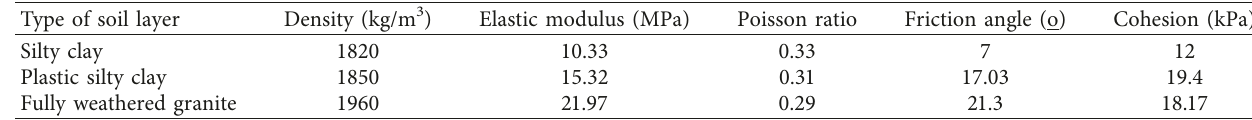
Table 1: Mechanical parameters of soil layers in the numerical model.